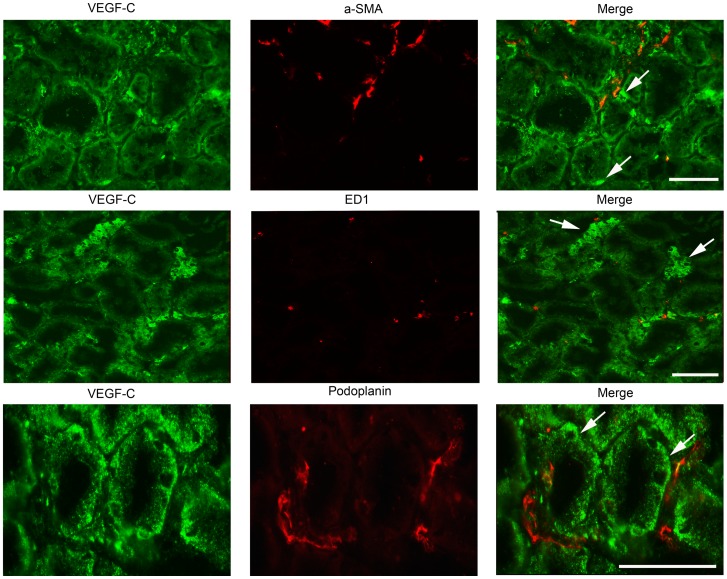
Double immunofluorescence staining for VEGF-C with α-SMA (myofibroblast), ED1 (macrophages), and with podoplanin (lymph vessels).Most podoplanin positive lymph vessels were observed close to tubules (mostly proximal) which showed VEGF-C expression at 12 weeks (arrows). After double staining for macrophages and myofibroblast, most of these interstitial cells were negative for VEGF-C. (Bar = 100 µm).